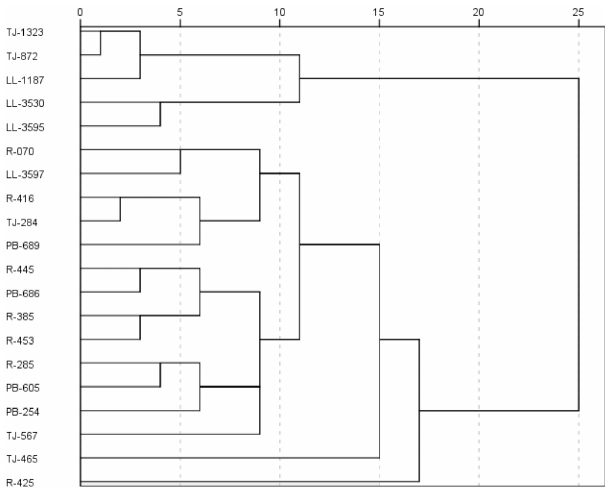
Figure 9. Dendrogram showing the clustering of sampled crude